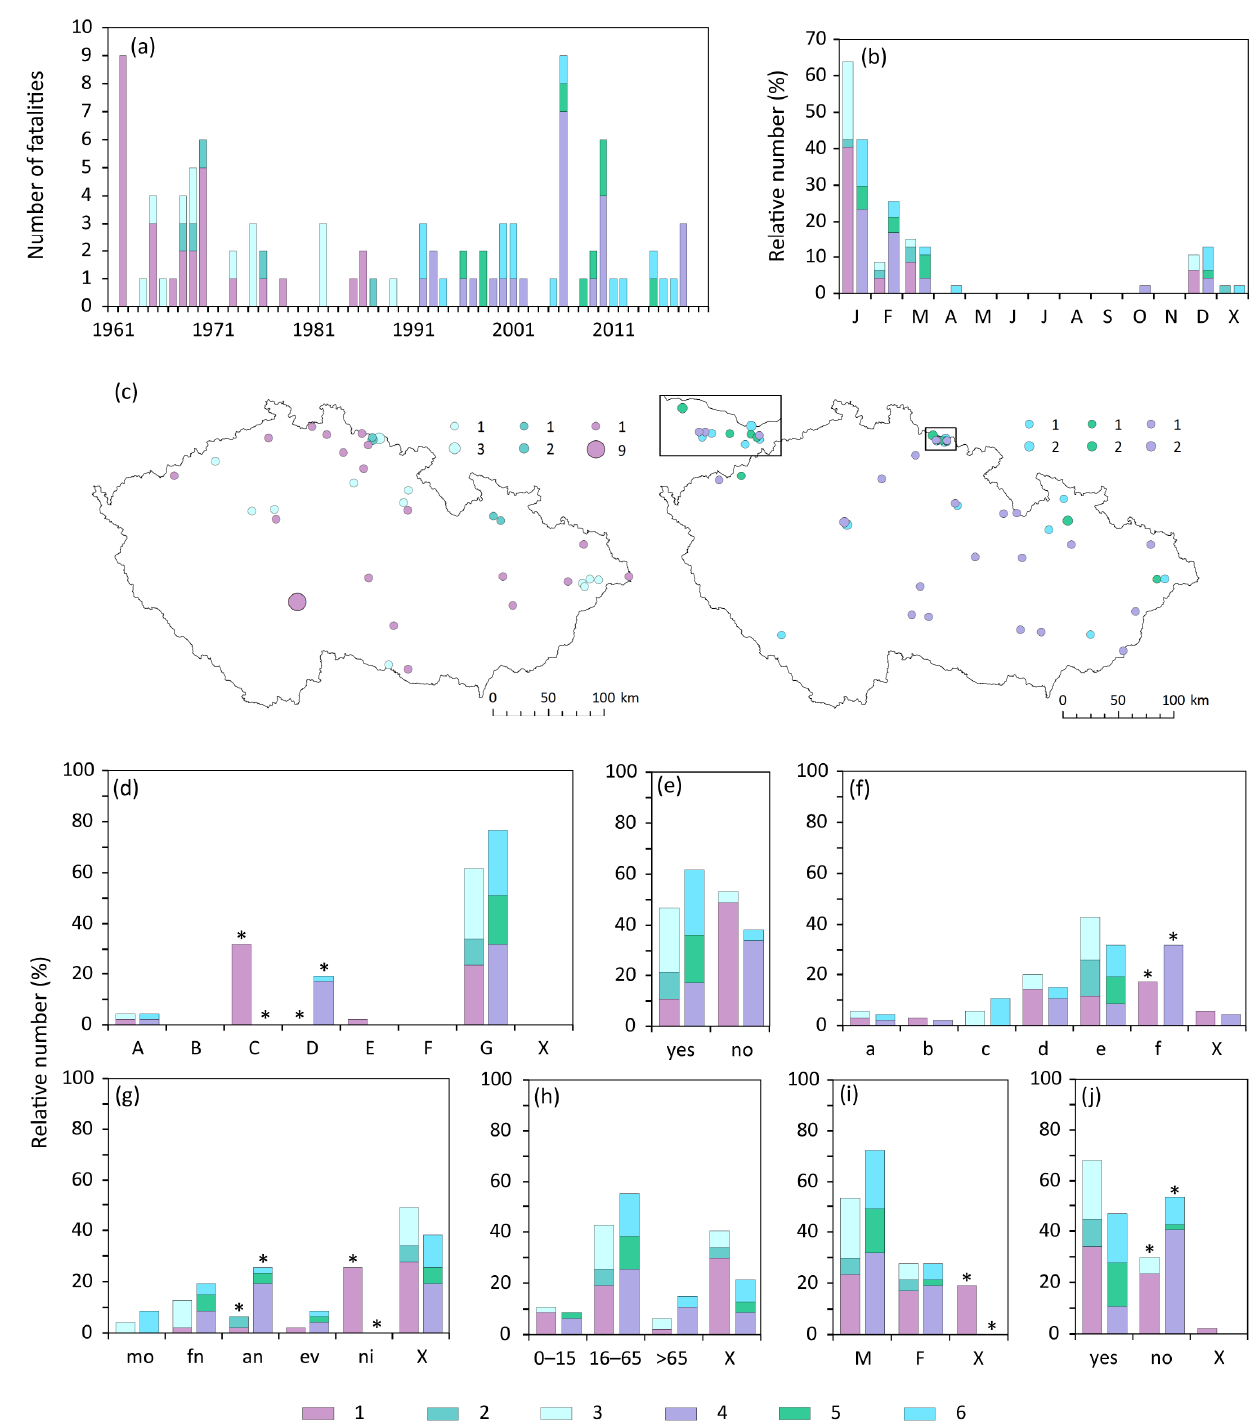
Figure 5. Characteristics of fatalities associated with snow and glaze ice in the Czech Republic during the 1961–1990 (1—snow, 2—avalanche, 3—glaze ice) and 1991–2020 (4—snow, 5—avalanche, 6—glaze ice) periods. ( a ) Fluctuations in 1961–2020; ( b ) annual variation; ( c ) spatial distribution (two fatalities in 1991–2020 lack exact location); ( d ) cause of death; ( e ) type of fatality (direct); ( f ) place of death; ( g ) time of day; ( h ) age; ( i ) gender; ( j ) behaviour (hazardous). For an explanation of symbols and abbreviations see Figure 2.